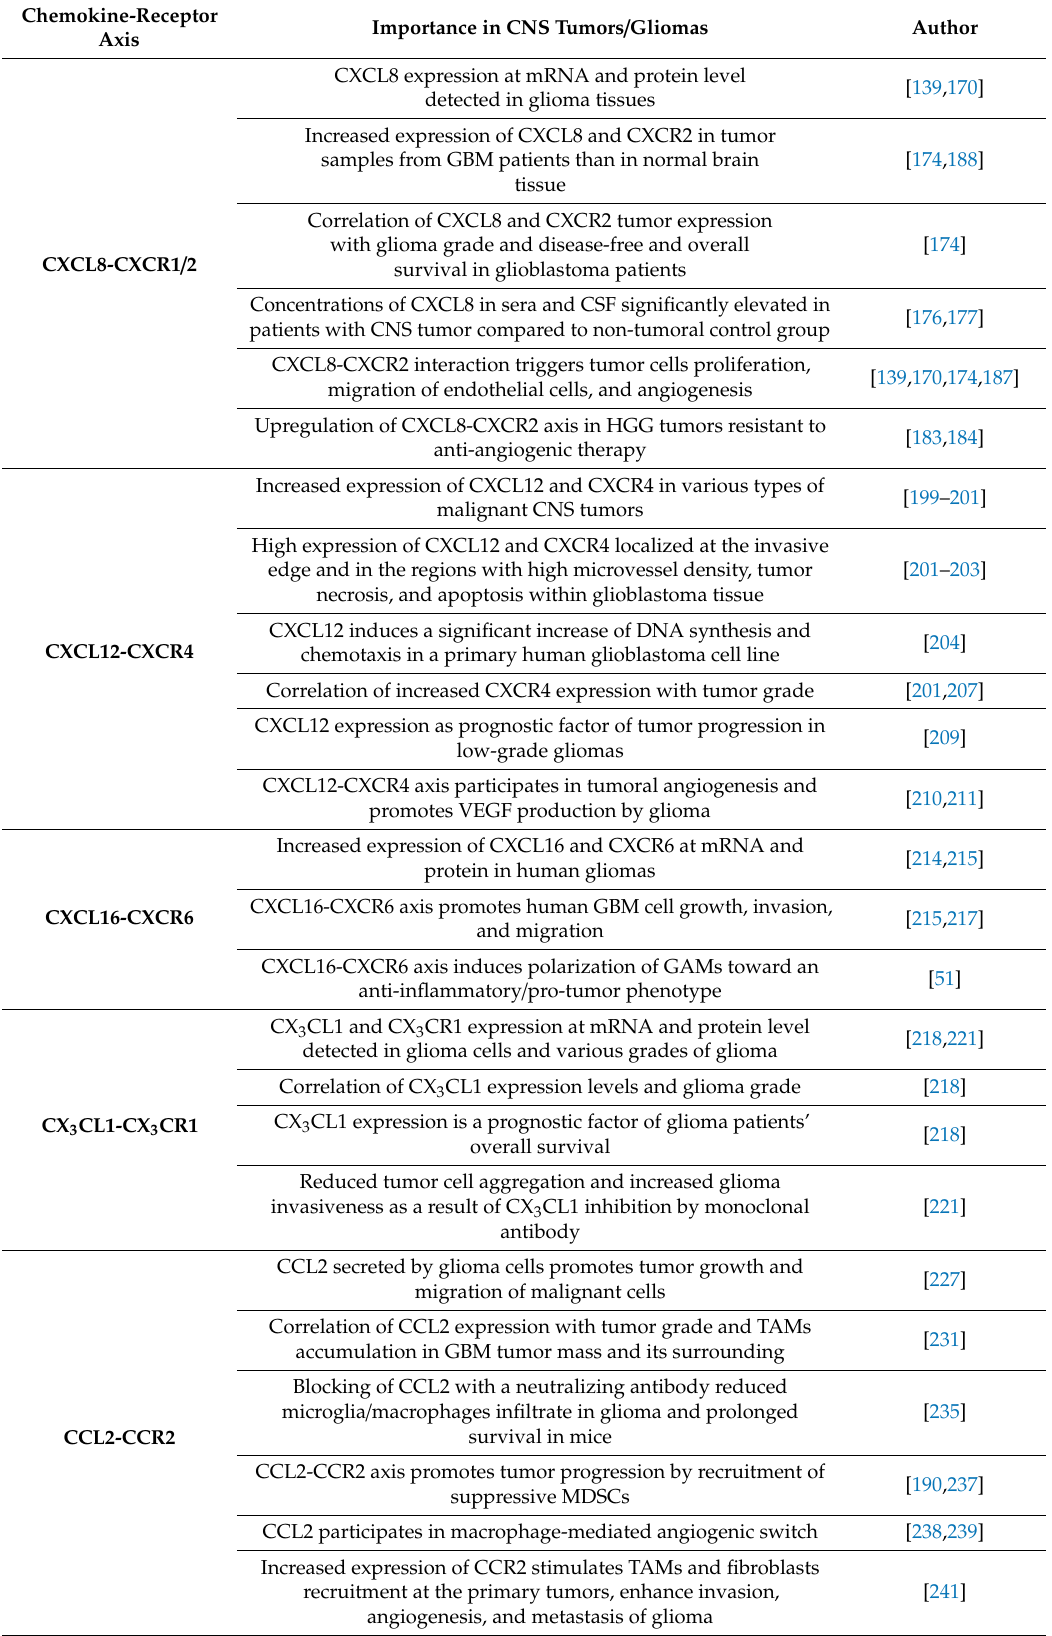
Table 1. Chemokine / receptor axes in